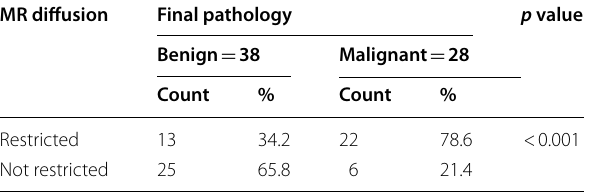
Table 6 Distribution of breast lesions according to the pattern of diffusion and its correlation to the final pathology results